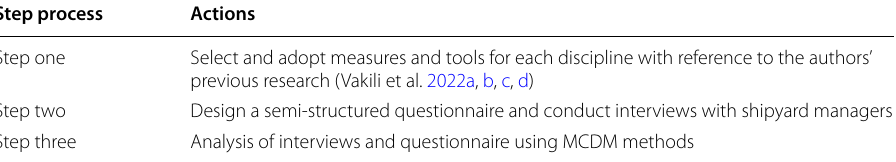
Table 3 Research methodology process